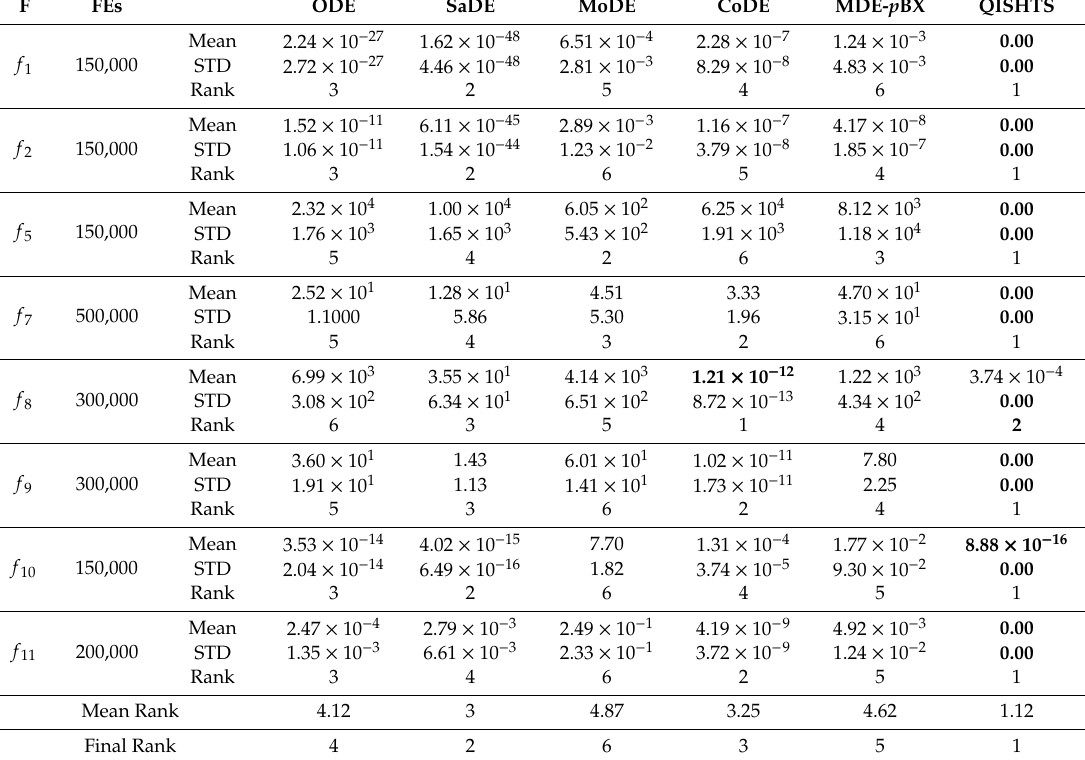
Table 5. Computational results for the QISHTS algorithm with the state-of-the art di ff erent evolutions (DEs) in Investigation 2. (The results of the competitors are adapted from the literature [63]). FEs: function evaluations, ODE: opposition-based di ff erential evolution, SaDE: self-adaptive di ff erential evolution, MoDE: modified di ff erential evolution, CoDE: composite di ff erential evolution, MDE- p BX: modified di ff erential evolution with p -best crossover, and QISHTS: quadratic interpolation